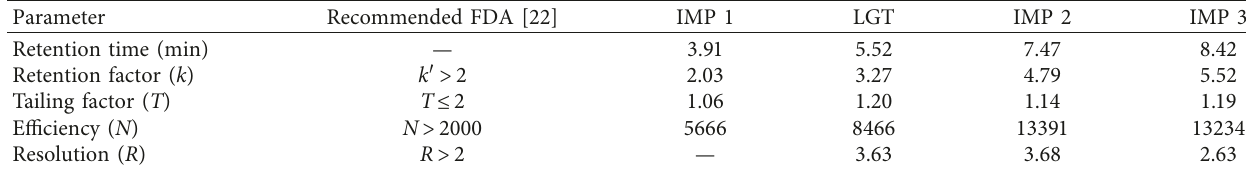
Table 1: Parameters of system suitability of the analytical method developed and results recommended by the FDA [25]. Parameter